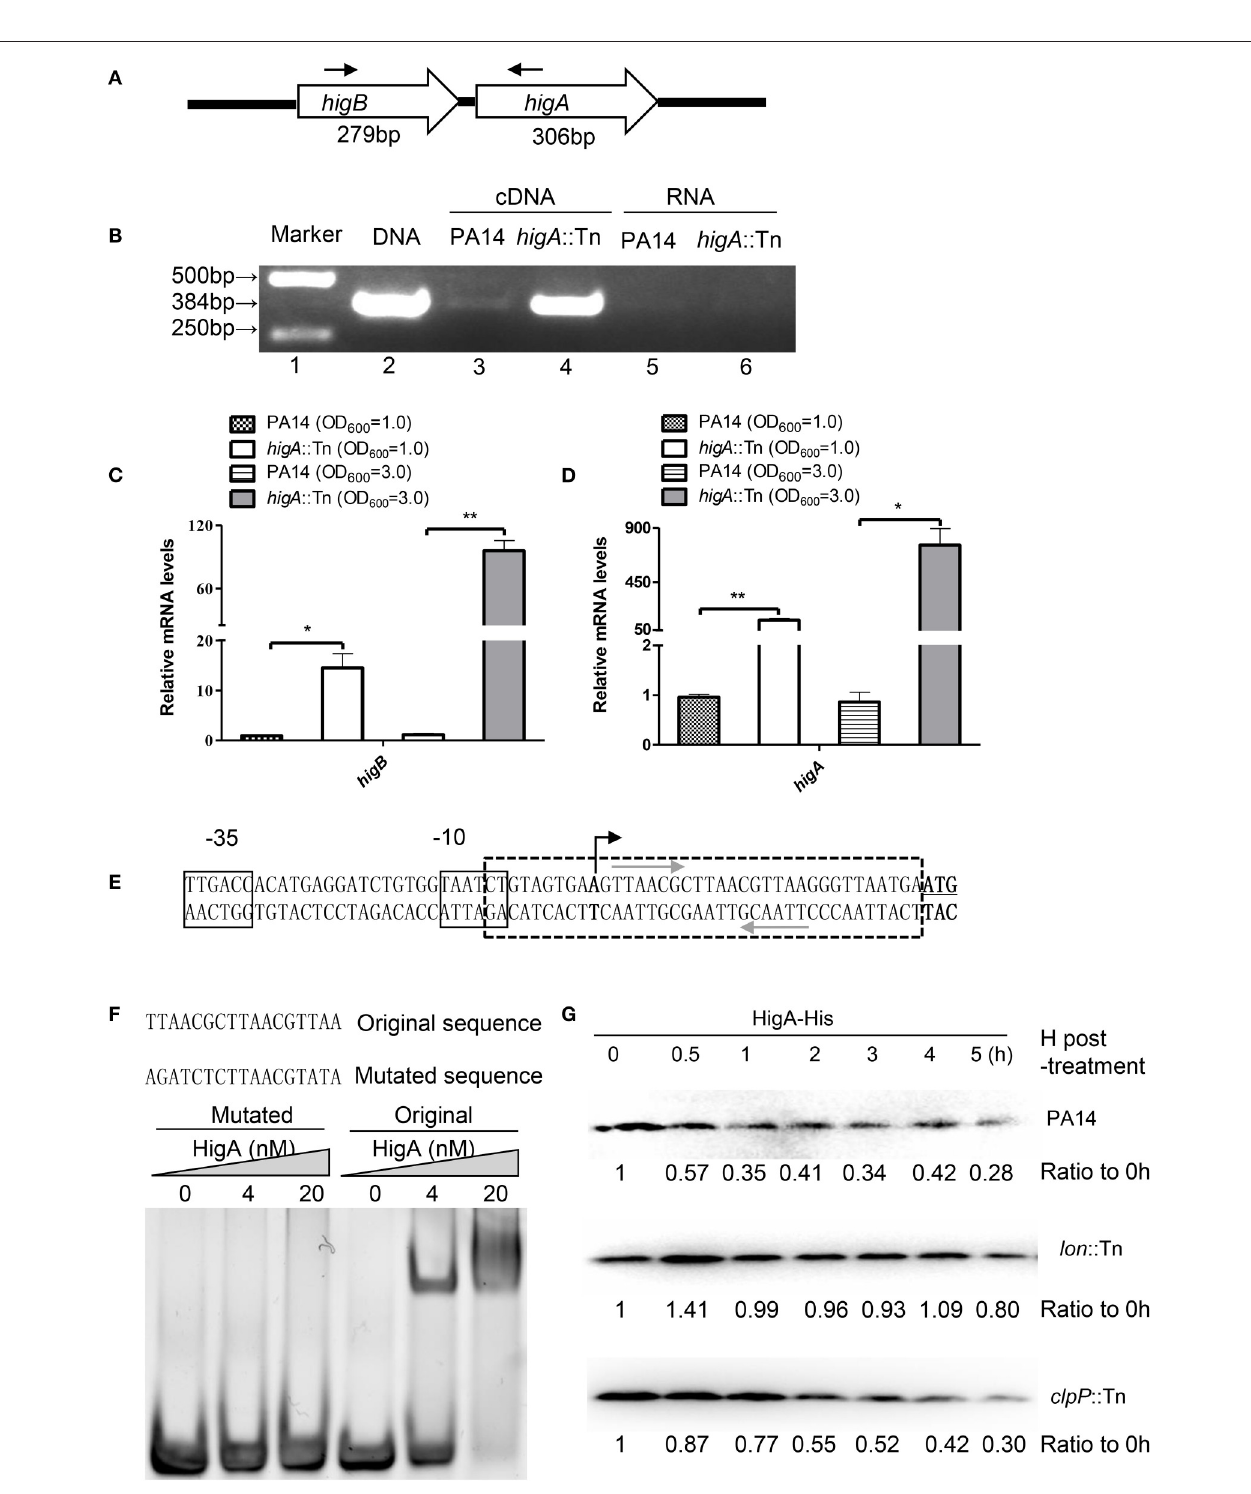
FIGURE 1 | HigA negatively regulates the higB - higA operon. (A) Sketch map of the higB - higA operon. Arrows indicate the directions and locations of the primers for RT-PCR. (B) Total RNA was isolated from PA14 and the higA ::Tn mutant. cDNA was synthesized and used as templates in PCR. RNAs were used in RT-PCR as negative controls. (C,D) The relative mRNA levels of higB and higA genes in PA14 and the higA ::Tn mutant. Total RNA was isolated and the mRNA levels were determined by quantitative RT-PCR with the 16S rRNA as the internal control. Data represents the mean ± standard deviation from three